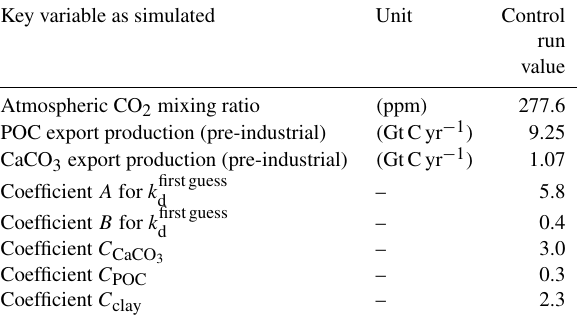
Table 1. Summary of control run results (run P0; see Table